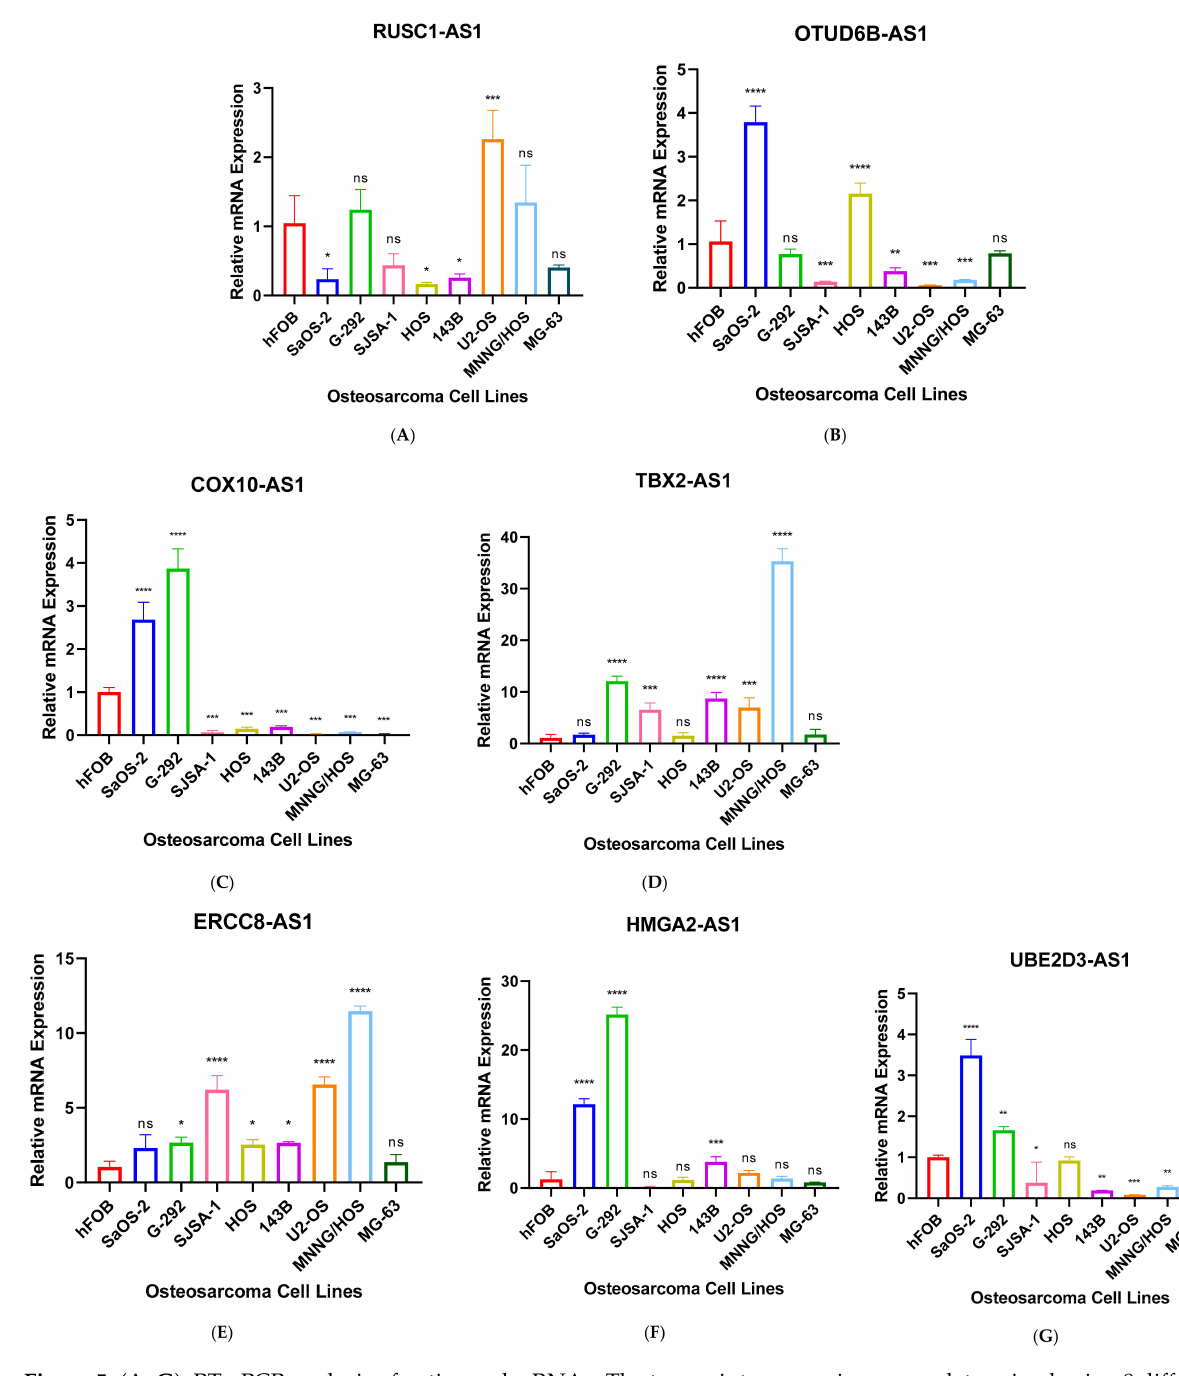
Figure 5. ( A – G ). RT-qPCR analysis of antisense lncRNAs. The transcripts expressions were determined using 8 different osteosarcoma cell line; SaOS-2, G-292, SJSA-1, HOS, 143B, U2-OS, MNNG/HOS, MG-63 and relative lncRNA expression obtained by hFOB expression. * p < 0.05, ** p < 0.01, *** p < 0.001, **** p <